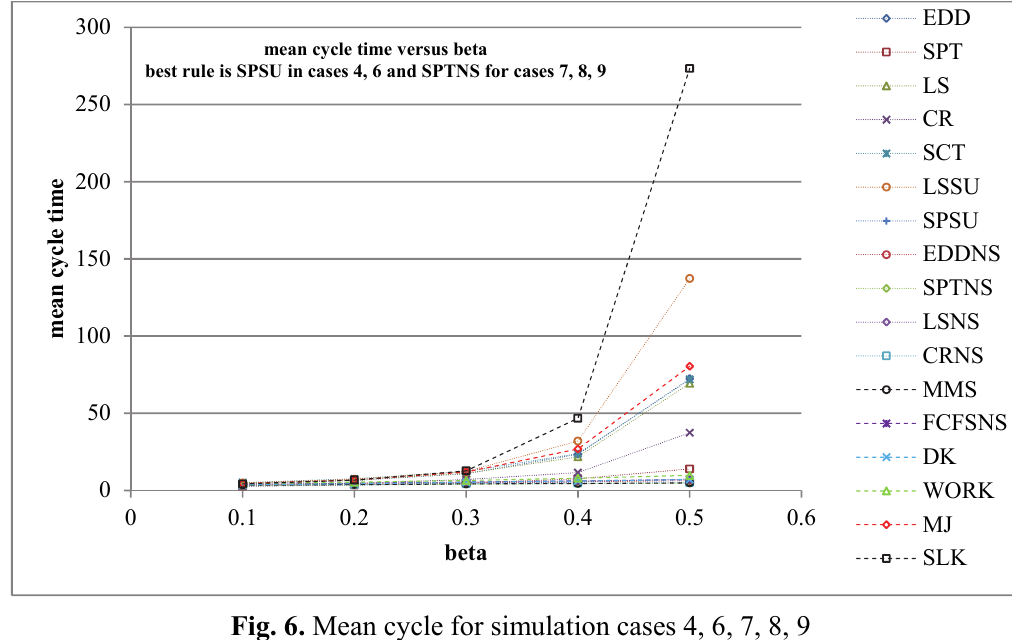
Fig. 6. Mean cycle for simulation cases 4, 6, 7, 8, 9